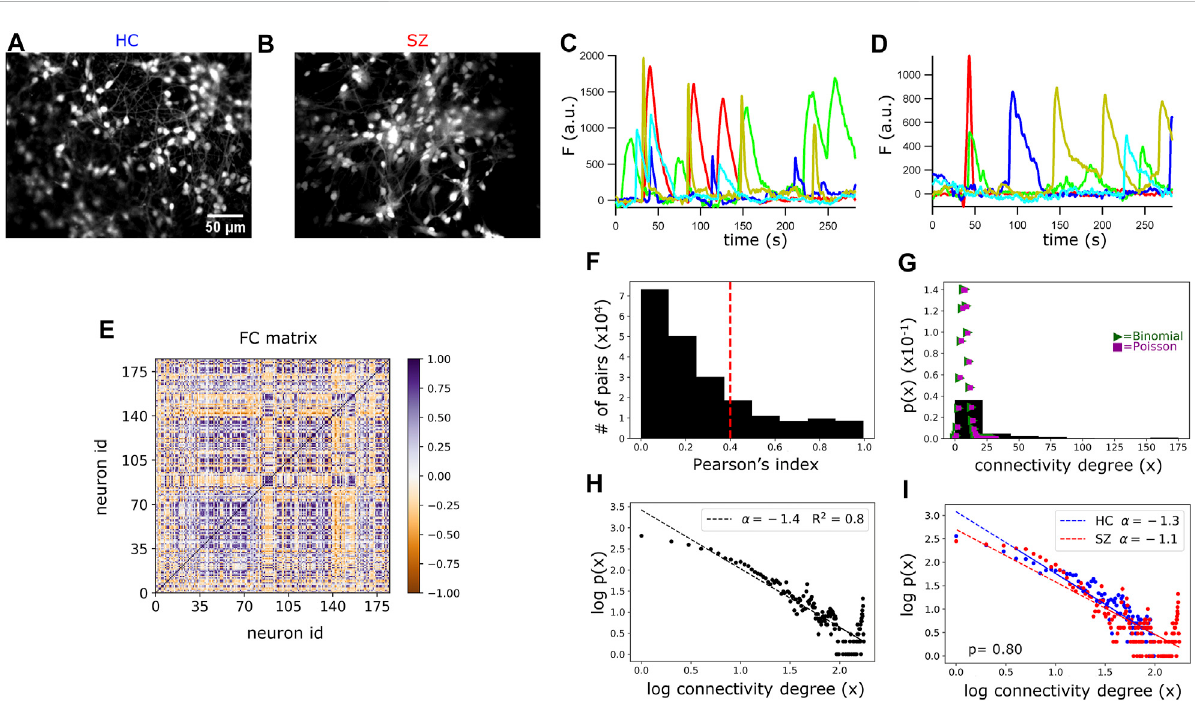
FIGURE 2 Functional connectivity (FC) and topology analysis in HC and SZ networks. (A,B) Representative ROI images of HC and SZ neuronal cultures loadedwiththeCa 2+ indicatorOGB-1. (C,D) Ca 2+ transients( fl uorescenceintensityafterbaselinecorrection)of5randomlyselectedneuronsinaHC andaSZnetwork. (E) RepresentativestaticFCmatrixdisplayingthePearson ’ scorrelationindexes(colorbar)between theCa 2+ signalsfromeachpair of neurons in a HC network, considering the whole recording time. (F) Frequency plot of the absolute Pearson ’ s correlation coef fi cients from every pair of neurons, considering all networks. The dotted red line indicates the threshold beyond which we considered a pair of neurons as functionally connected. (G) Probability density of fi nding a neuron with x functional connections(connectivity degree). The connectivity distribution doesnot fi ttoaPoisson( λ =8)nortoaBinomial(n=1,000, p =0.008)distribution. (H) Scatterplotoftheconnectivitydegreelogarithm(log 10 )vs.the probability logarithm. Data fi t a scale-free or long-tailed distribution, with a scaling exponent of − 1.4. (I) Scale-free fi tting of neurons connectivity degree in SZ and HC networks. Connectivity scaling exponents were fi tted with a mixed effect regression model detailed in Methods. The scaling exponents did not signi fi cantly differ between the two groups. p -value